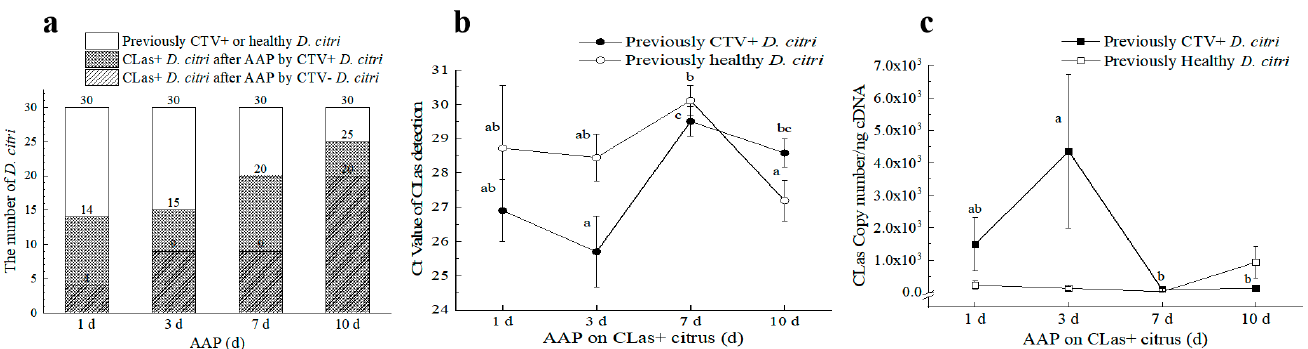
Figure 5. Effects of Citrus tristeza virus (CTV) on ‘ Candidatus Liberibacter asiaticus’ (CLas) acquisition on CLas–carrying Citrus tangerine Hort. Ex Tanaka by previously CTV+CLas − or CTV − CLas − D . citri adults. ( a ) The number of CLas+ D . citri after different AAPs; ( b ) The average Ct value of CLas carried by the two D . citri populations after feeding; ( c ) Comparison of CLas content between CTV+ D . citri and healthy D . citri after different feeding days. CLas+: CLas positive; CTV+: CTV positive; CTV − : CTV negative; Different letters in the figure ( b , c ) indicate significant differences at p < 0.05